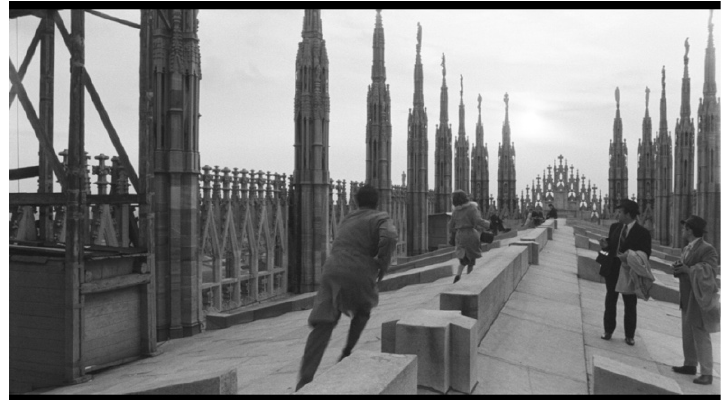
Figure 3 Screenshot from Rocco and His Brothers. (Goffredo Lombardo.)